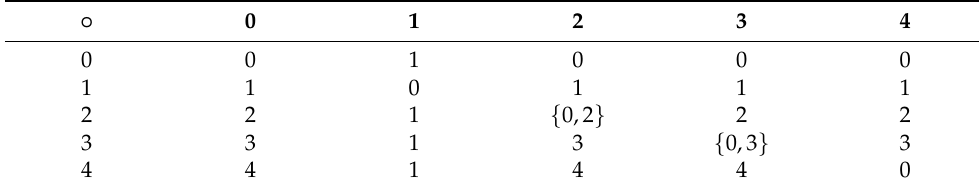
Table 3. QM-hyper BZ